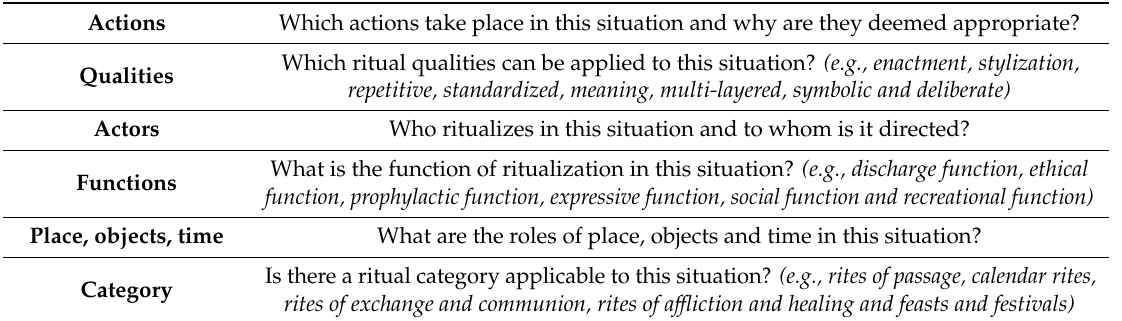
Table 1. Framework for